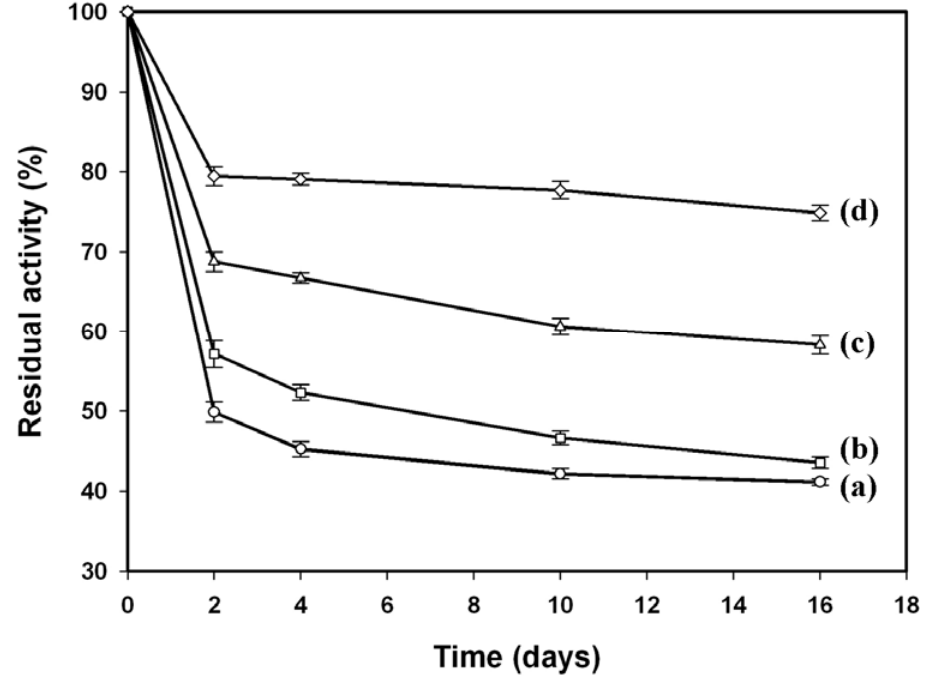
Figure 7. The current responses of (a) PANI/Pt, (b) GA/HRP/PANI/Pt, (c) SBA-15(HRP)/PANI/Pt, and (d) GA/SBA-15(HRP)/PANI/Pt electrodes to 1.96 mM H in a 16-day period with multiple measurements. The data were collected from three separate experiments on the same